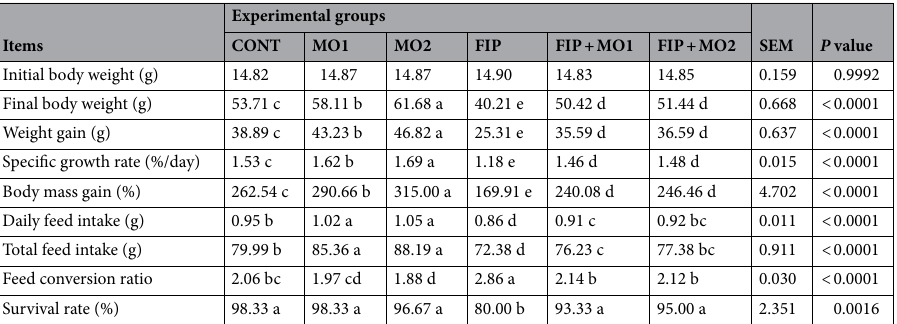
Table 2. Growth performance, feed utilization indices and survival rates of Nile tilapia groups during the present study. Data represent means ± S.E.M—means having different letters in the same row are significantly different at P <